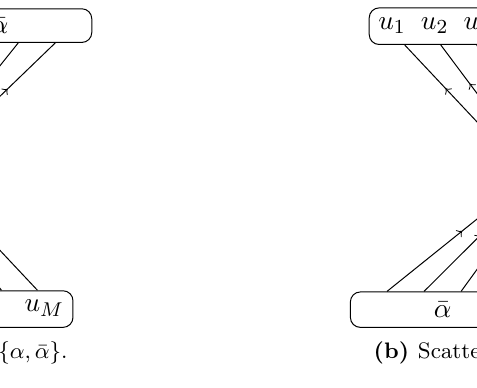
Figure 13. Multi-scattering R -matrices in (E.83) and